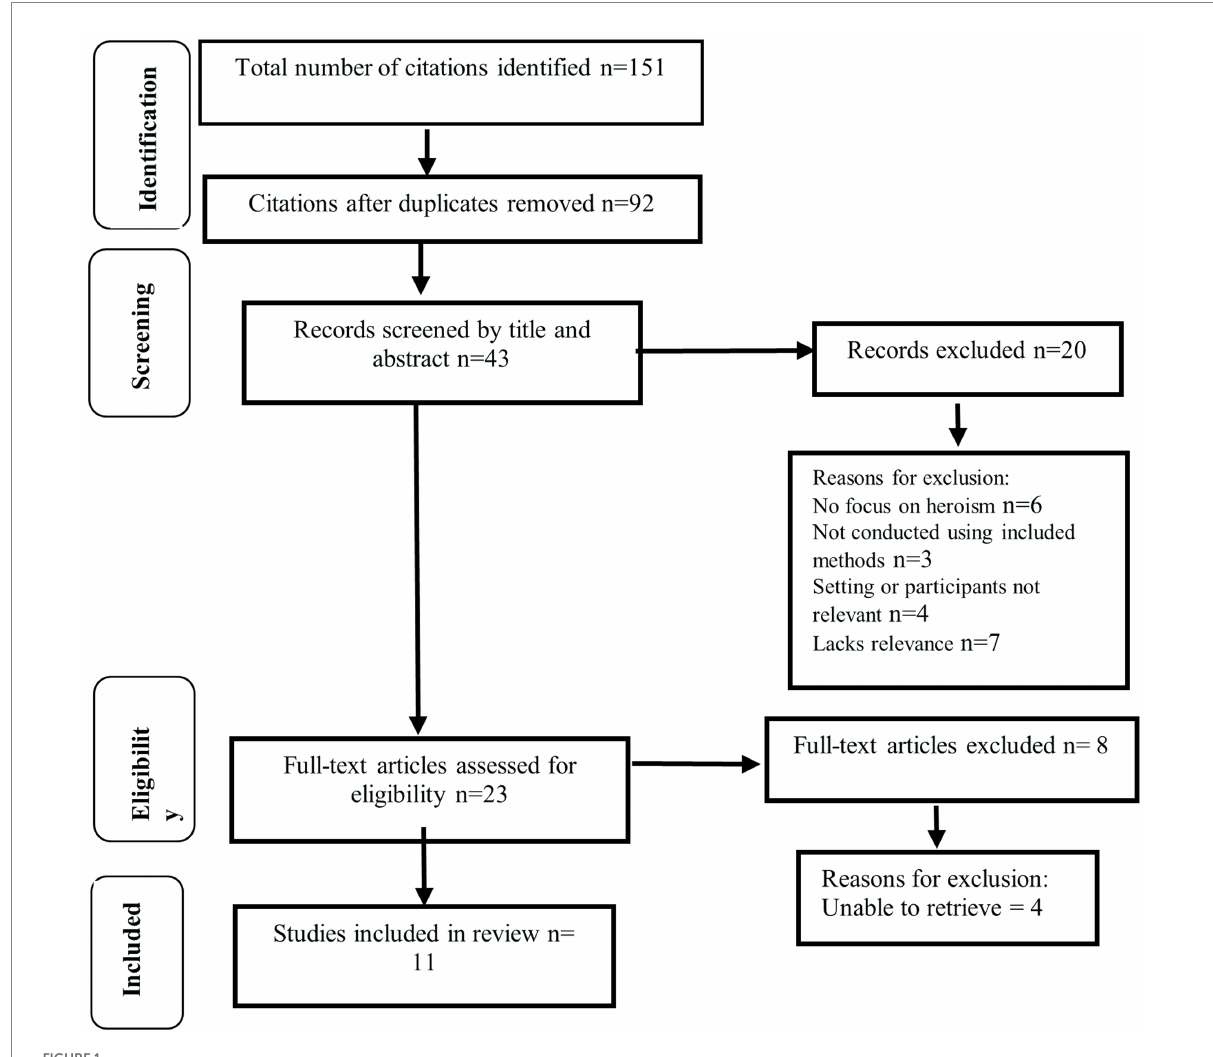
FIGURE 1 PRISMA-P chart of studies screened and in the final